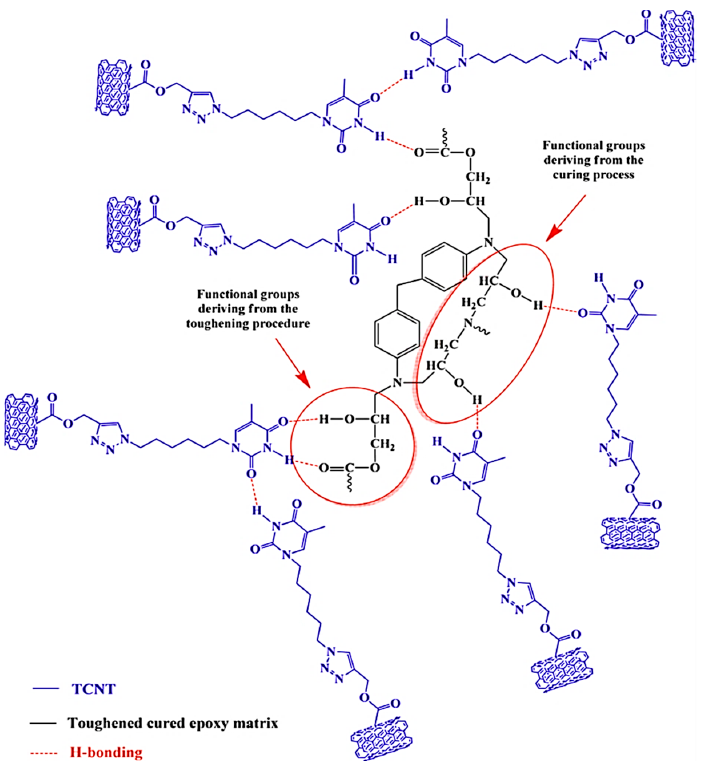
Figure 6. Representation of supramolecular network generated into the cured sample ETCNT TCNT = carbon nanotube functionalized with thymine; ETCNT = epoxy/carbon nanotube functionalized with thymine-based ligand. Reprinted with permission from [108]. 2021, Elsevier.